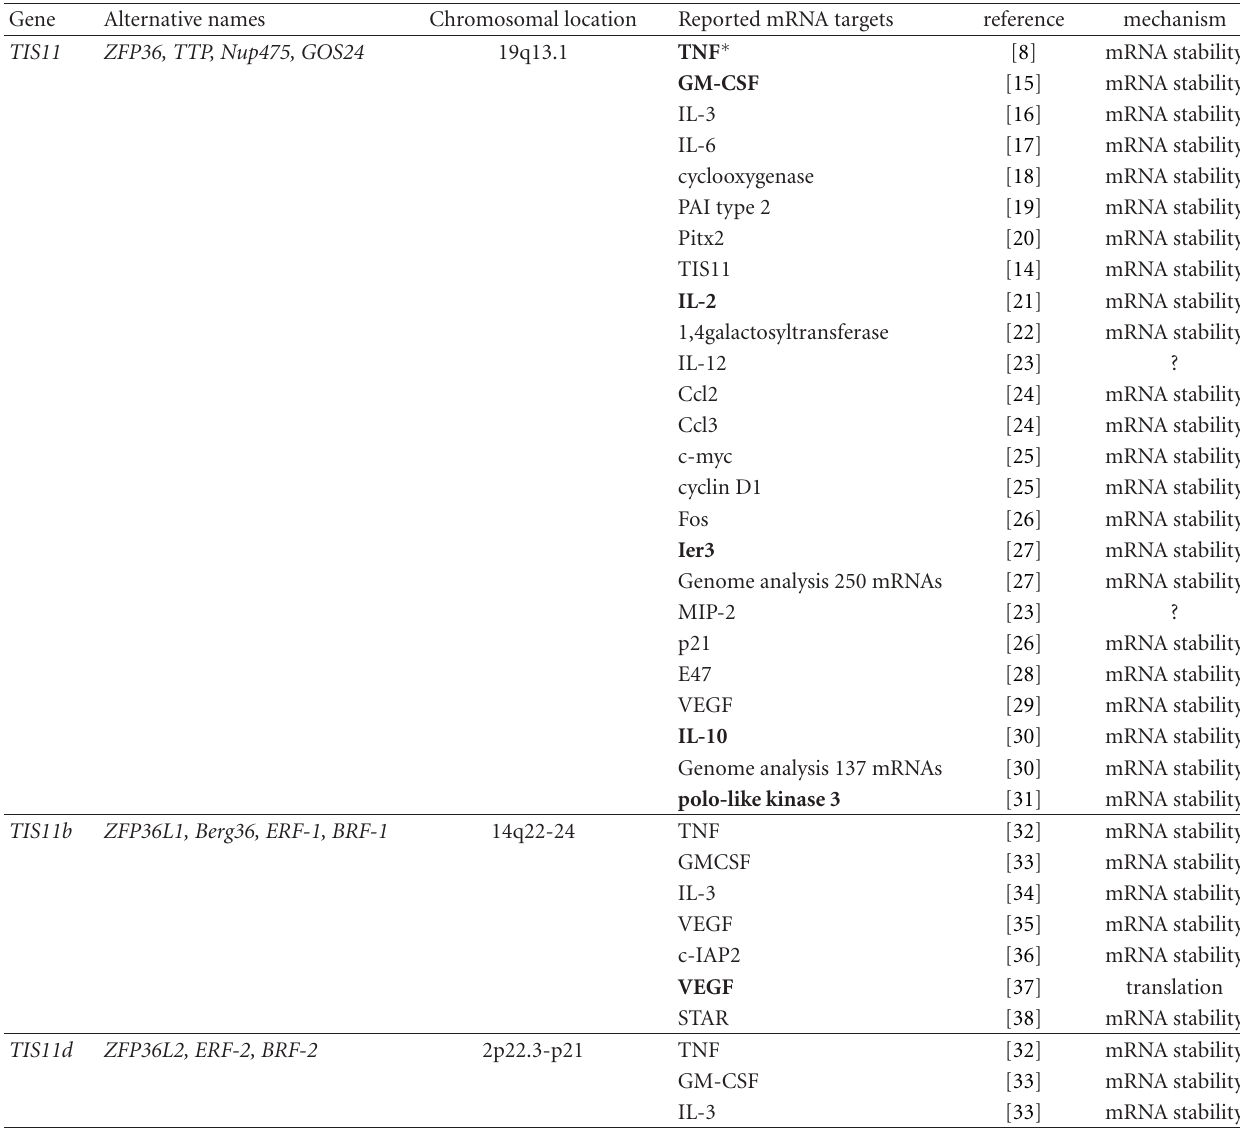
Table 1: Human TIS11 family members and reported mRNA targets of the TIS11